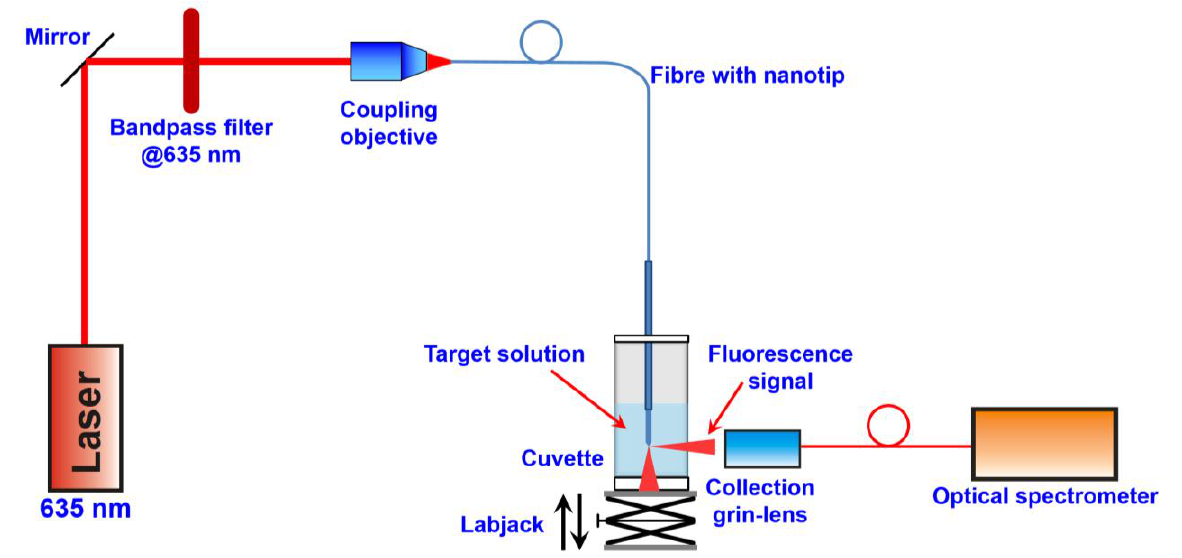
Figure 3. Optical experimental